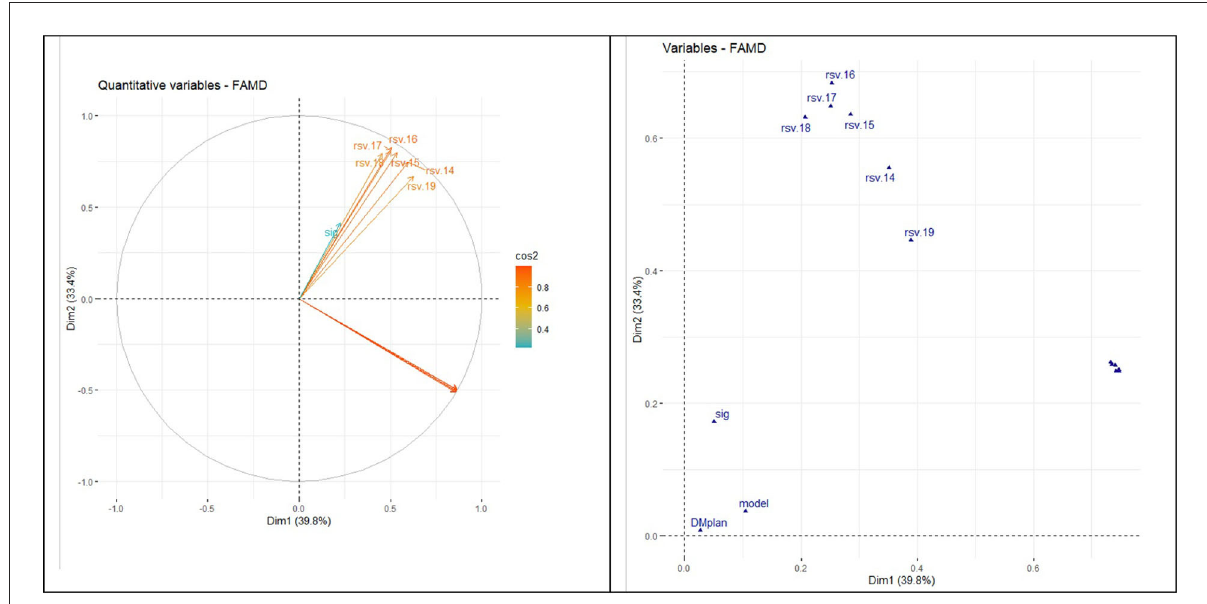
FIGURE5 Relationship between quantitative and qualitative variables (dimensions 1 and